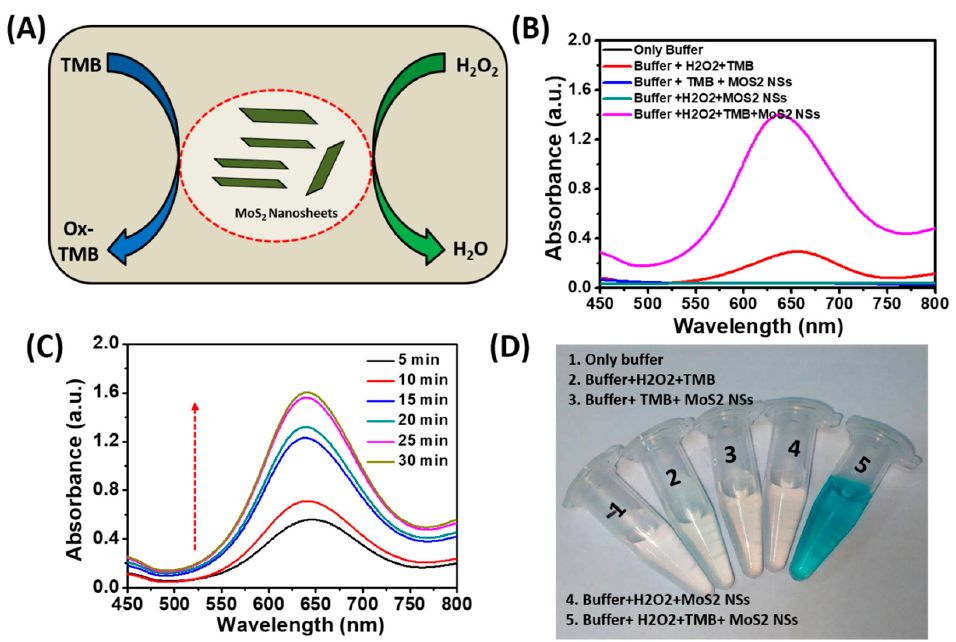
Figure 6. Peroxidase activity of B1-MoS 2 NSs. ( A ) Schematic representation of peroxidase mimetic activity. ( B ) TMB oxidation absorption spectra at various conditions. ( C ) Time dependent peroxidase activity of B1-MoS 2 NSs. ( D ) Color visualization of TMB oxidized product on peroxidase mimic B1-MoS 2 NSs.